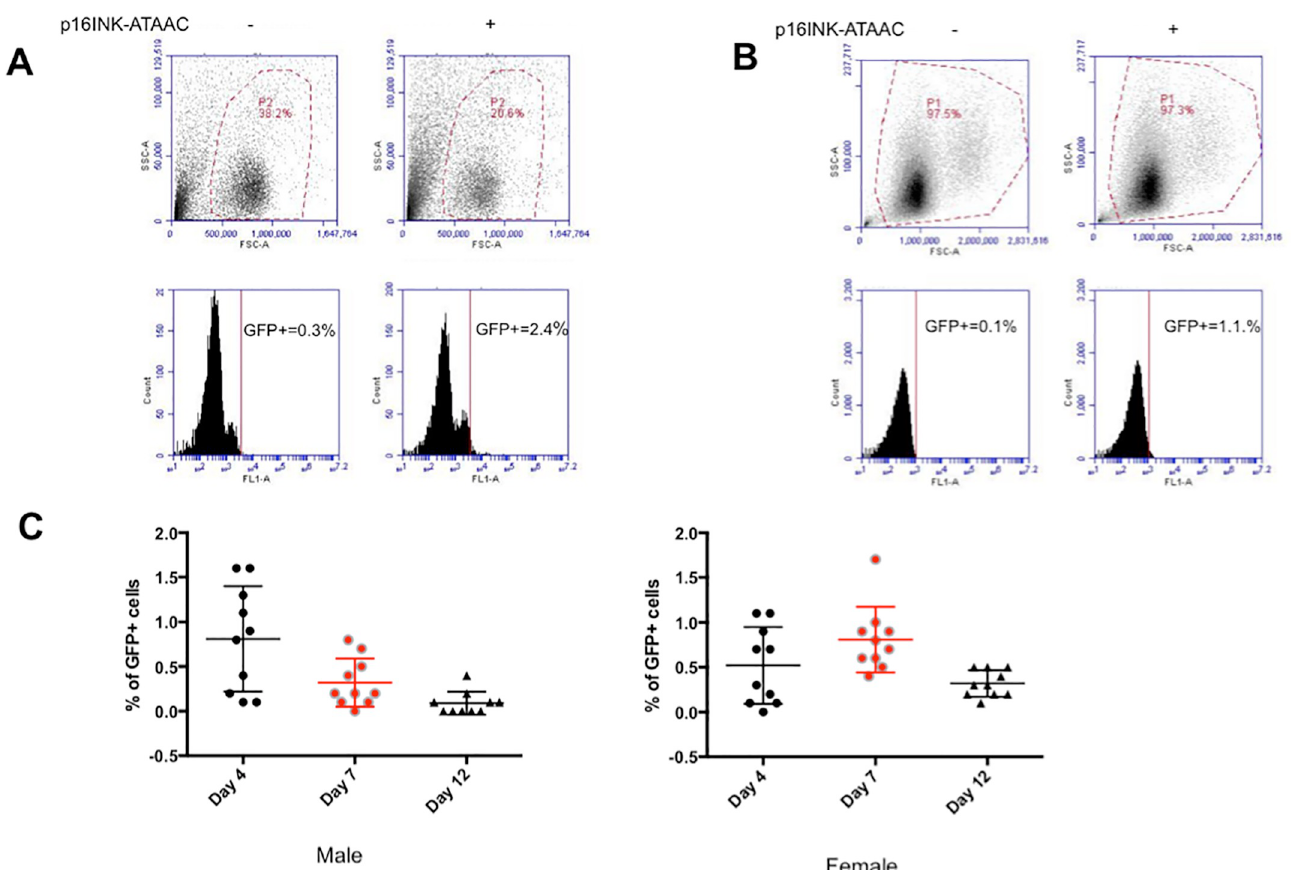
Fig 1. p16 INK-ATTAC+ mouse is an established mouse model studying cellular senescence. (A) GFP positive cells were detected in adipose tissue of p16 INK-ATTAC+ mouse [FL1: 530 ± 15nm (FITC/GFP)]. (B) Senescent cells were observed in white blood cells after two doses of doxorubicin treatment in p16 INK-ATTAC mice. (C) The dynamics of the senescent cells population post-chemo (Female: n = 10; male: n =